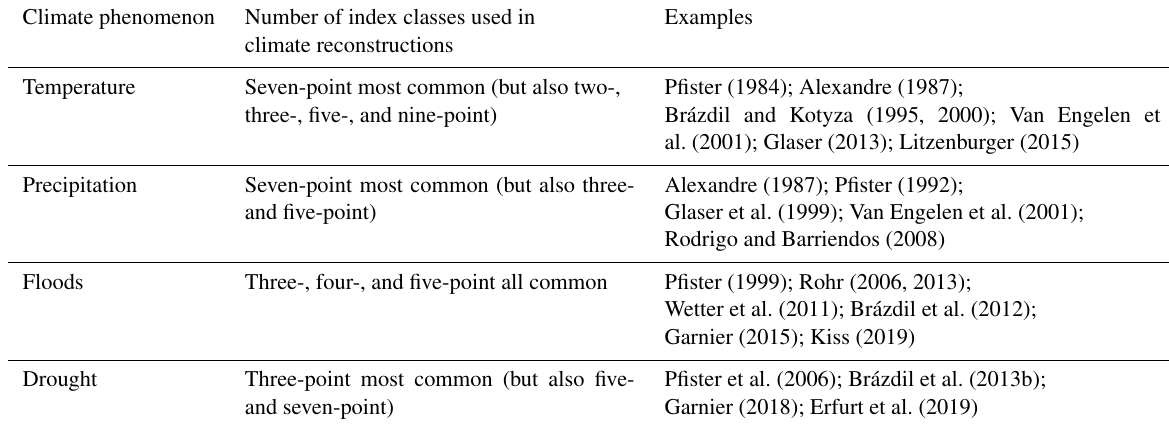
Table 6. Variability in the number of index classes used in index-based historical climate reconstructions across Europe. Climate phenomenon